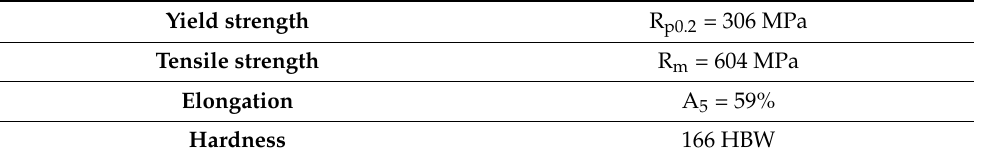
Table 2. Mechanical properties of the 316L austenitic steel (20 ◦